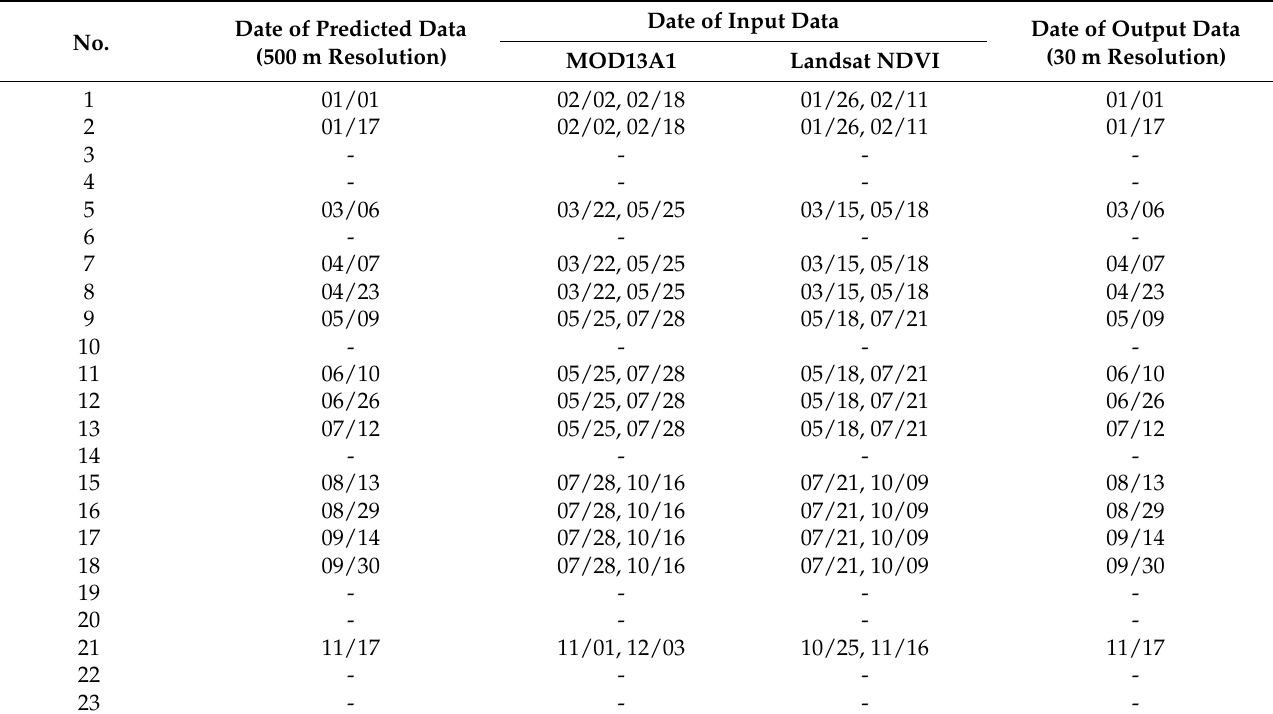
Table 8. List of dates of images used in the ESTARFM model to generate NDVI time